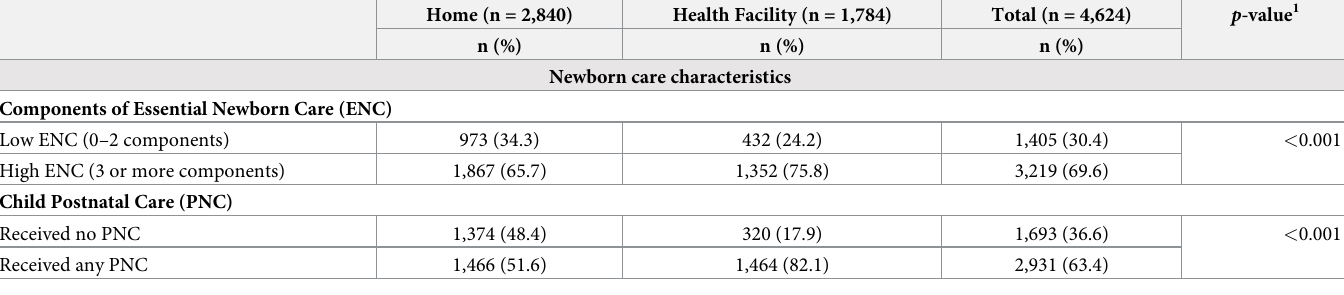
Table 4. Distribution of essential newborn care and postnatal care by place of delivery among most recent live births in the three years preceding the survey, Ban- gladesh DHS